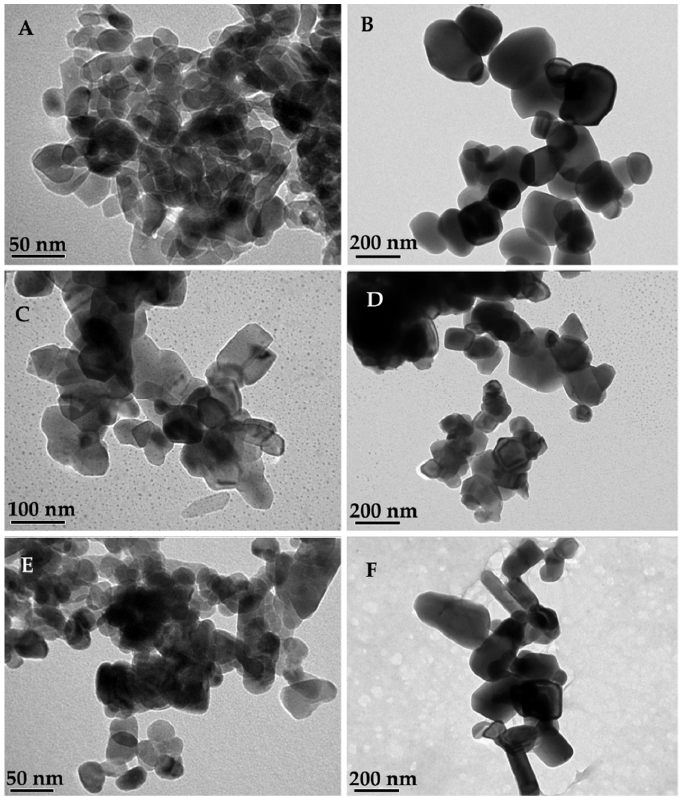
Figure 1. TEM images of ( A ) anatase 40 nm, ( B ) anatase 100 nm, ( C ) rutile 50 nm, ( D ) rutile 100 nm, ( E ) ZnO 35–45 nm, and ( F ) ZnO 80–200 nm.